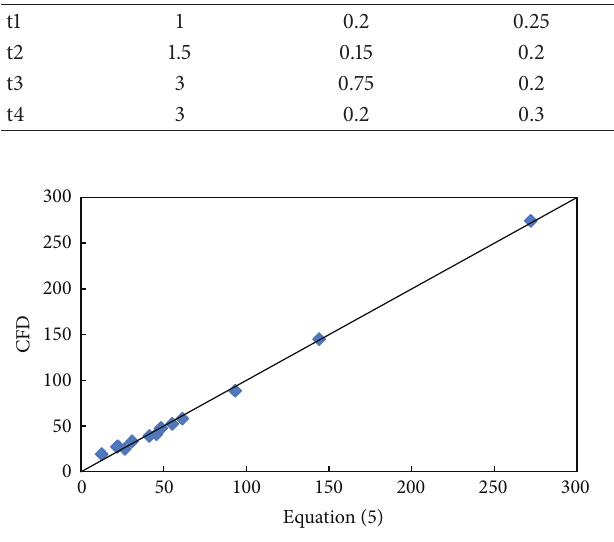
Figure 5: Results of the regression analysis.